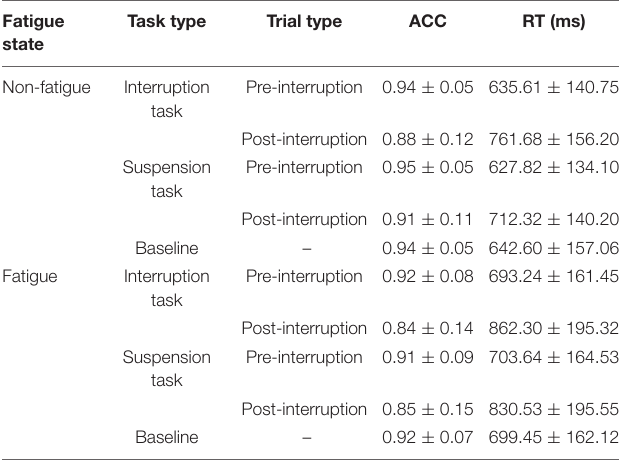
TABLE 2 | Descriptive statistics of behavioral data in various conditions (Mean ±